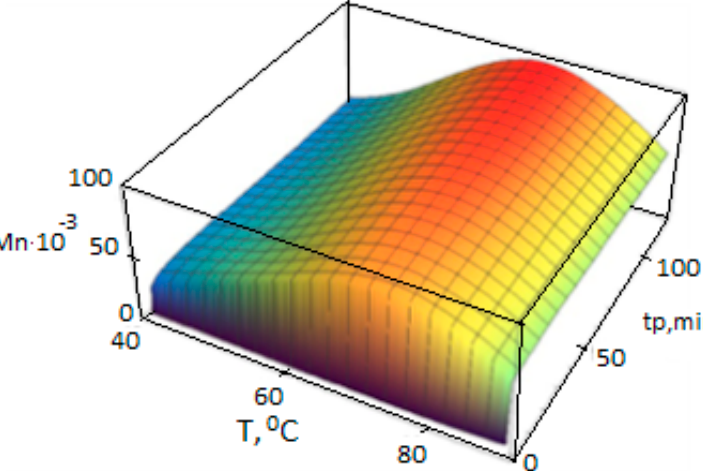
Figure 6. Dependence of the polydispersity coefficient of PP on the temperature T and the polymer- ization duration t p , calculated according to the polycenteric model using the activation energies from Table 3 (polymerization conditions in Table 2).